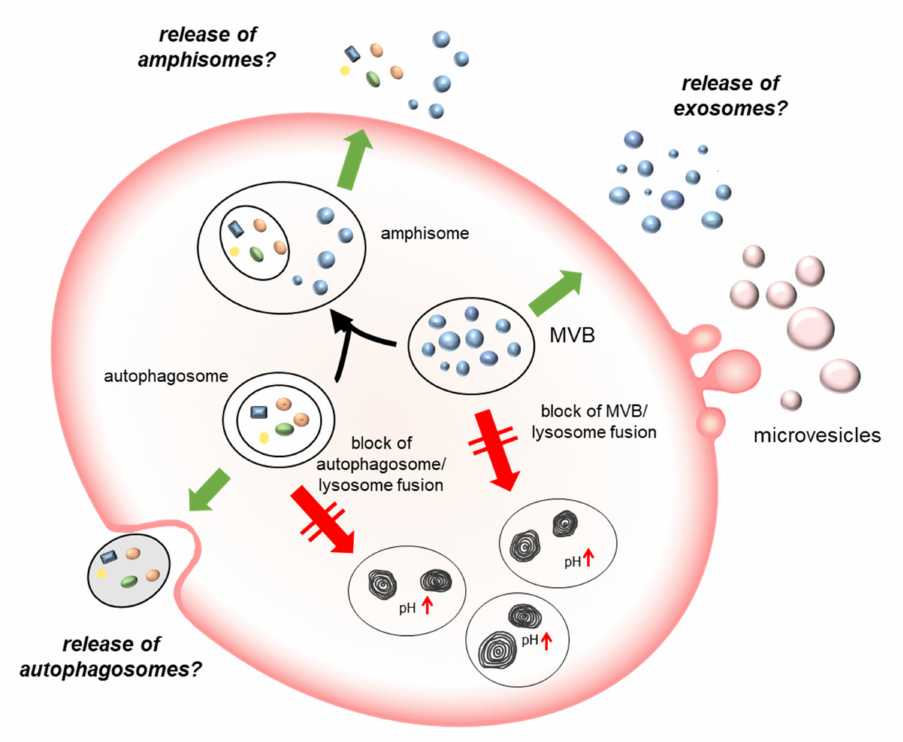
Figure 10. Schematic representation showing the mechanisms of DIPL and EVs release . The lysosomal dysfunction induced by the presence of undigested substrates is associated with the release of EVs enriched in autophagy markers. In the diagram, it is hypothesized that the reason may be an increased release of autophagososomes, because of the block of autophagosome/lysosome fusion, or of amphisomes, due to the block of amphisome/lysosome fusion. The release of exosomes may be induced as response to the block of MVB fusion with lysosomes and microvesicle secretion enhanced to maintain plasma membrane homeostasis after the increment of fusion events with organelles of the autophagy/lysosomal system. MVB, multivesicular